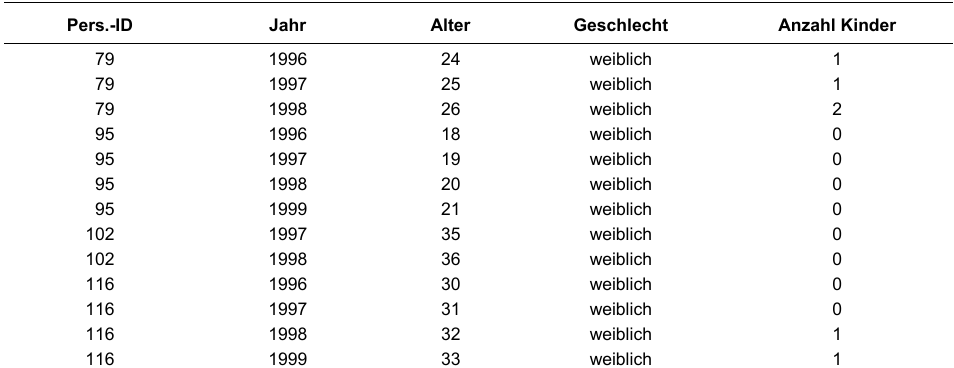
Tab. 1: Datensatz nach Zusammenführung der einzelnen Befragungsjahre